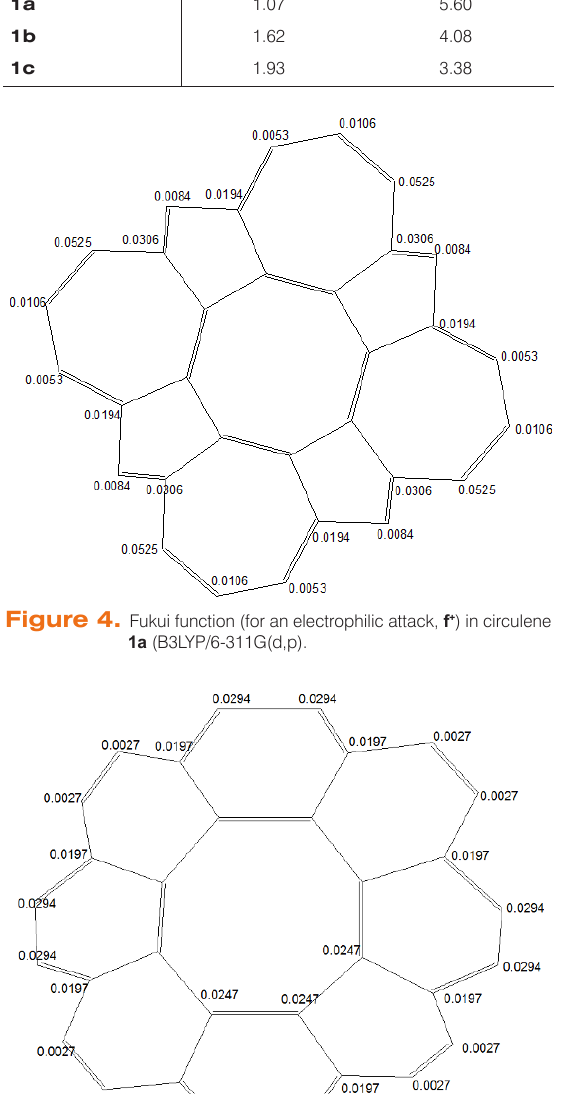
Table 7. Absolute hardness ( (cid:75) ) and electrophilicity ( (cid:90) ), computed at B3LYP/6-311G(d,p) level of theory. Circulene